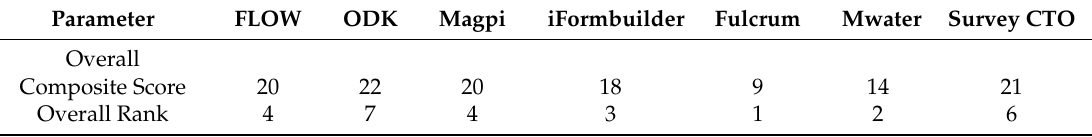
Table 16. Equal-weighted composite score and overall rank (lowest composite score is